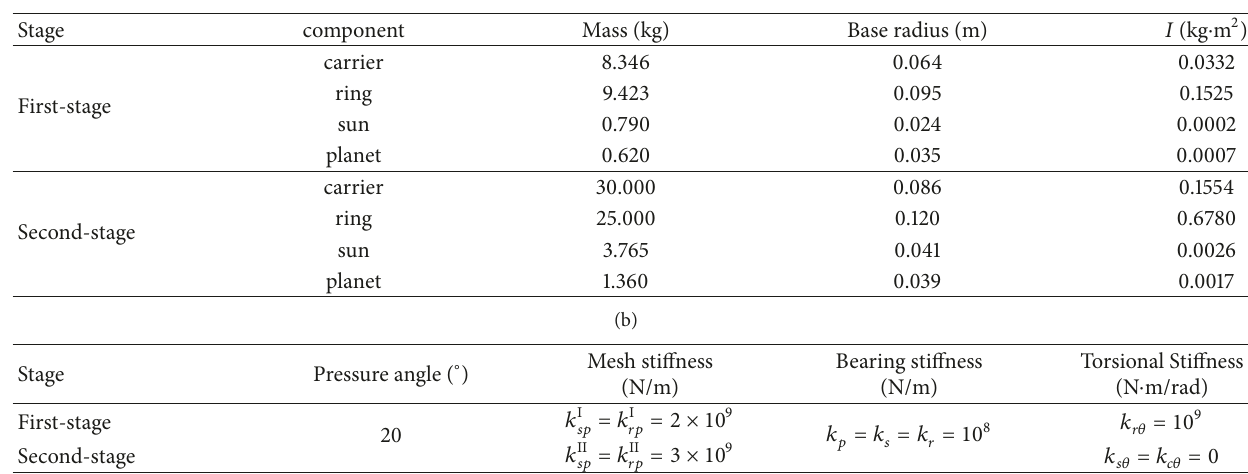
Table 1: Essential parameters of the two-stage planetary gear subsystem.